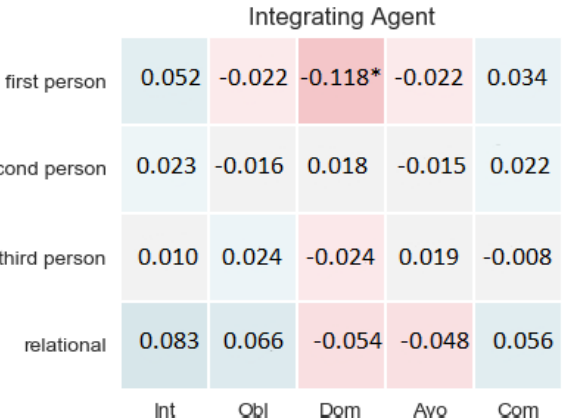
Figure 7. Correlation coefficients between first person, third person and relational pronouns used during the interaction with the Compromising virtual agent and the ROCI-II scores. (*) Significant values ( p < 0.05) are marked with asterisks.